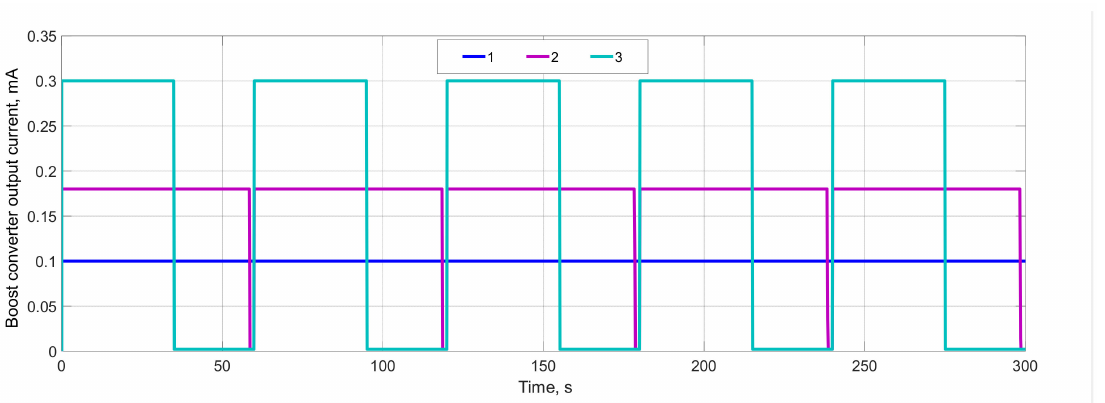
Figure 13. Virtual oscillograms of the WSN current.